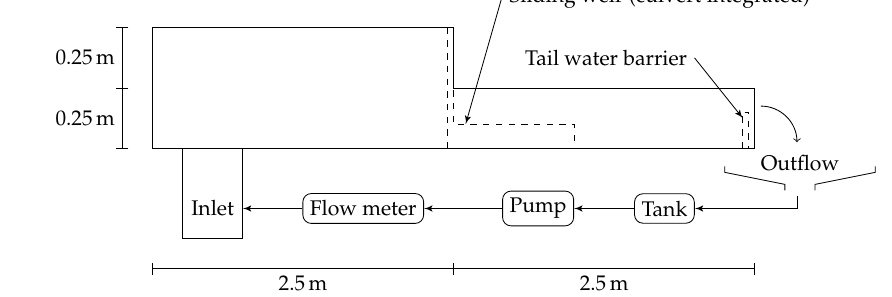
Figure A1. Schematic sideview of the experimental flume.